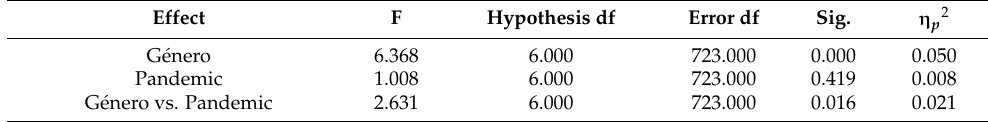
Table 8. Significance values and effect size of the variables gender vs. pandemic.